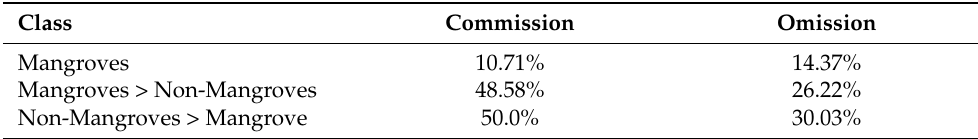
Table 10. The estimated omission and commission for each of the classes, which can be used with Equations (3) and (4) to adjust the mapped extents for the GMW